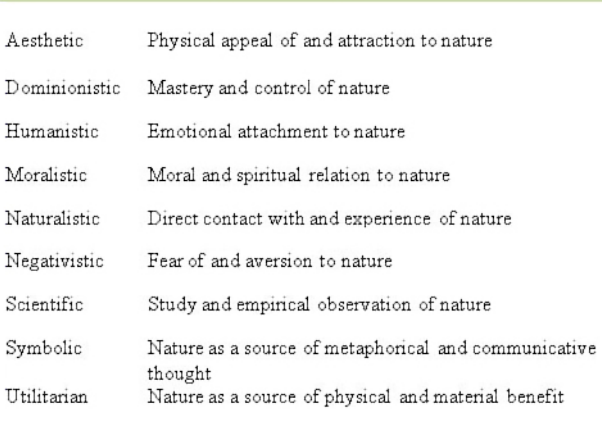
Fig. 2 . Adapted from Gullone 2000 and Kellert